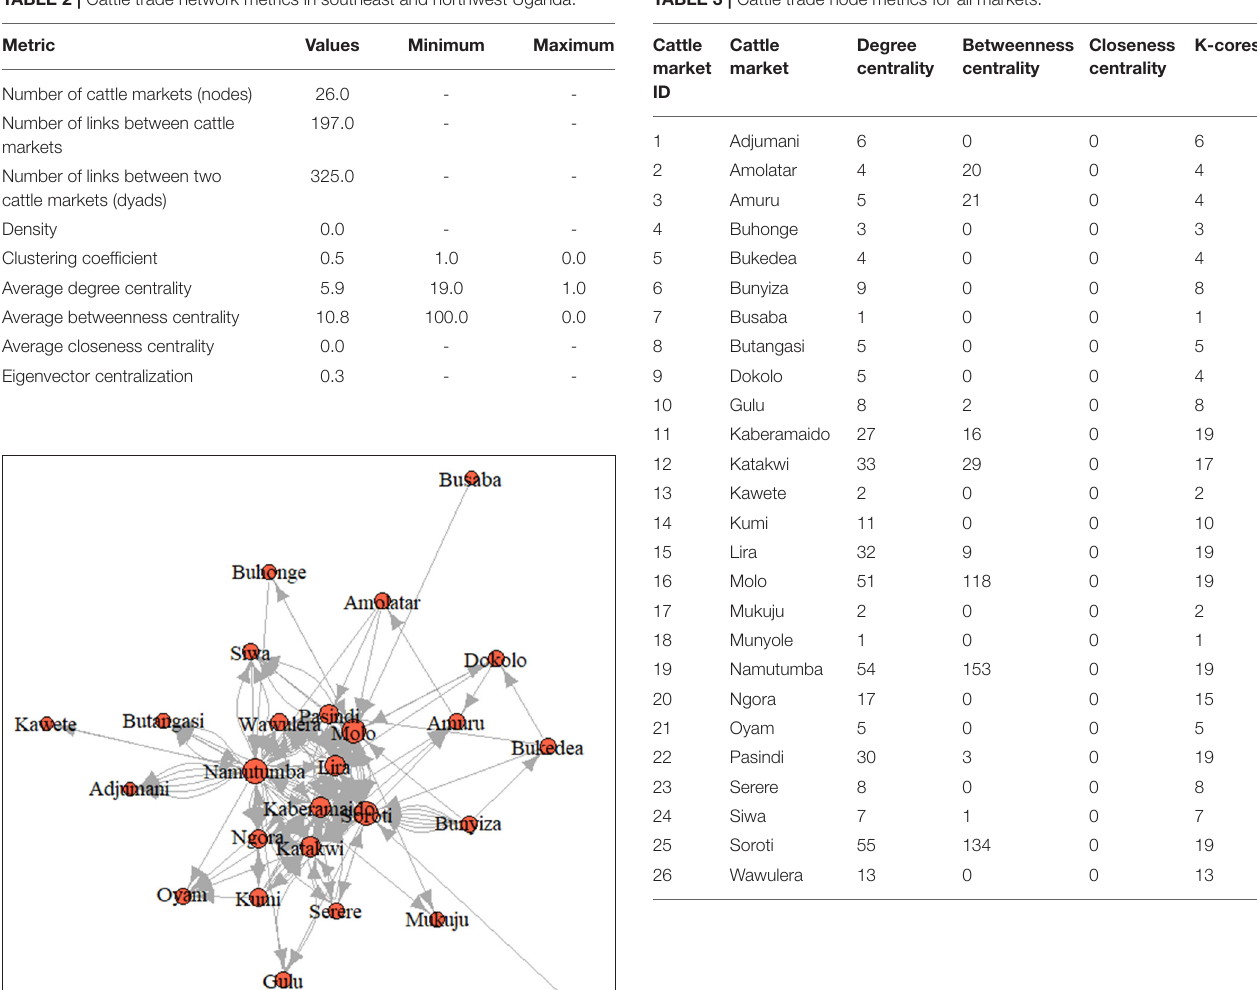
TABLE 3 | Cattle trade node metrics for all